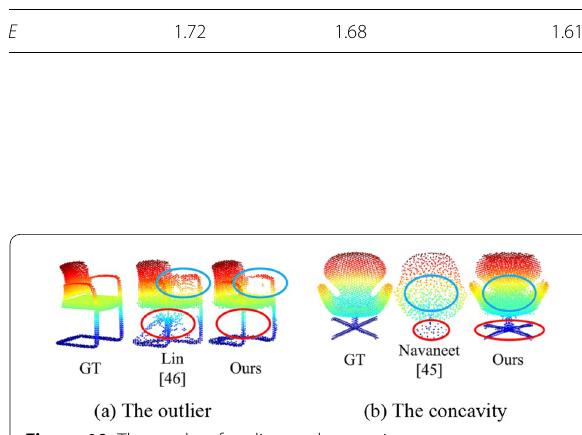
Figure 10 The results of outliers and